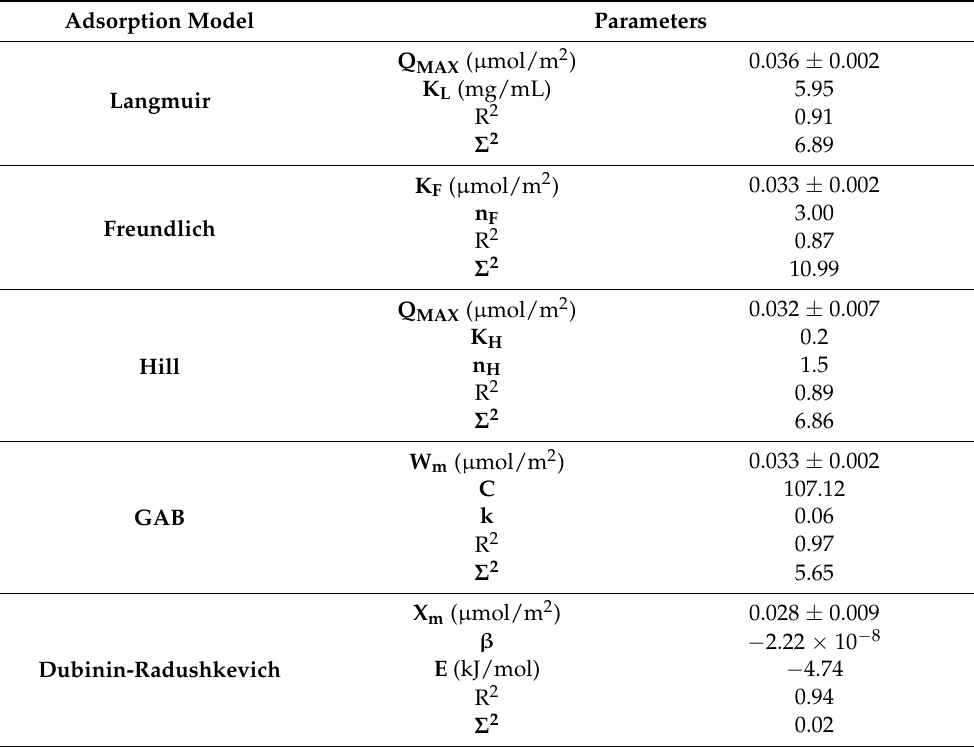
Table 1. Parameters of the adsorption of CALB lipase on Ns SiO 2 at 30 ◦ C according to Langmuir, Freundlich, Hill, Guggenheim–Anderson–de Boer GAB and Dubinin–Radushkevich models.